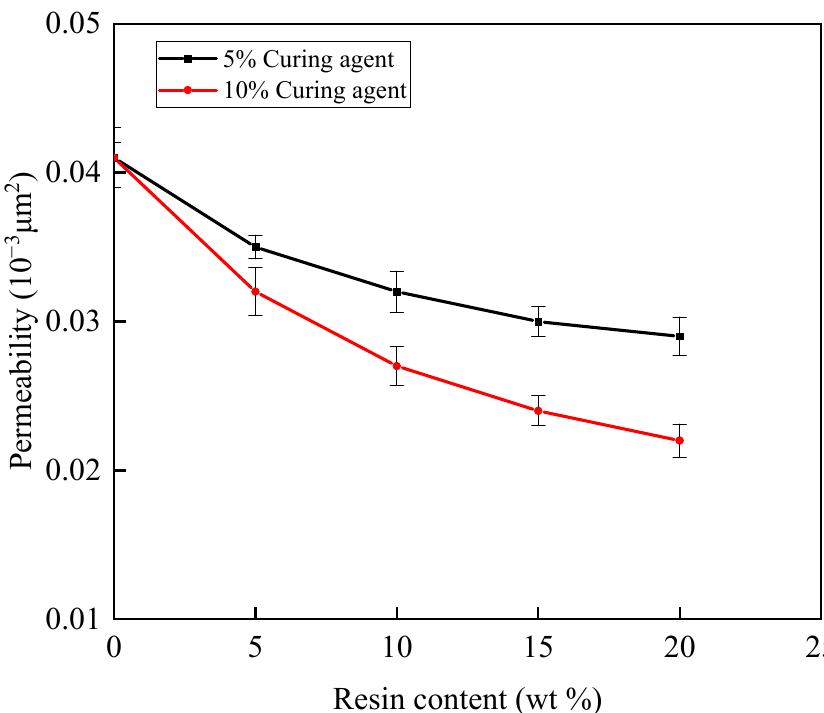
Figure 12. Permeability of conventional cement under different resin content. A high-quality cement sheath is required for effective gas containment within the wellbore annulus. The sealing ability of the conventional cement sheath is shown in Figure 13. The injection pressure is gradually increased, and the monitoring pressure is zero before the gas passes through the cement sheath and casing combination. As the monitoring pressure rises due to gas escape, the injection pressure drops abruptly. After being basically the same, the pressure on both sides gradually increases due to the injection side’s continuous gas injection. The cement sheath’s maximum sealing pressure without resin is 10.3 MPa. The maximum sealing pressure of the cement sheath mixed with 10% and 20% resin is 12.2 and 14.7 MPa, respectively, which is 18.5% and 42.7% greater than the maximum sealing pressure of the pure cement sheath. It demonstrates that adding resin improves the compressive strength of the hardened cement paste and the tightness of the cement sheath. It is worth noting that the rate of change of the injection pressure and the monitoring pressure (inside the green dotted line) is clearly different after the cement sheath seal failure. Figure 13a shows two rapid pressure changes. Figure 13b,c shows relatively flat pressure changes. The occurrence of an unobstructed gas pathway through the bonding interface between the cement and casing is evidenced by the rapid convergence of the injection pressure and monitoring pressure values. Along the gas channel, the cement and casing are devoid of any interfacial bonding force. However, the addition of resin to the cement extends the time that is required for the injection pressure and monitoring pressure values to converge following the gas breakthrough, particularly when the pressure differential is small and the curve is more gradual. These observations suggest that the bonding interface retains some bonding strength even in the presence of a gas channel, resulting in a delay in the attainment of maximum monitoring pressure values and a possible reduction in the rate of pressure buildup in the wellbore